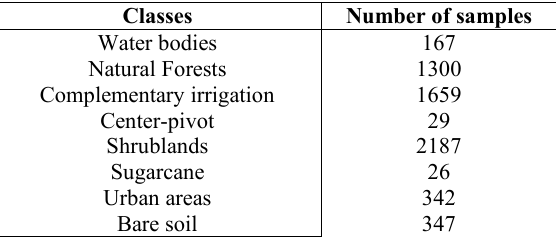
Table 1 . Number of